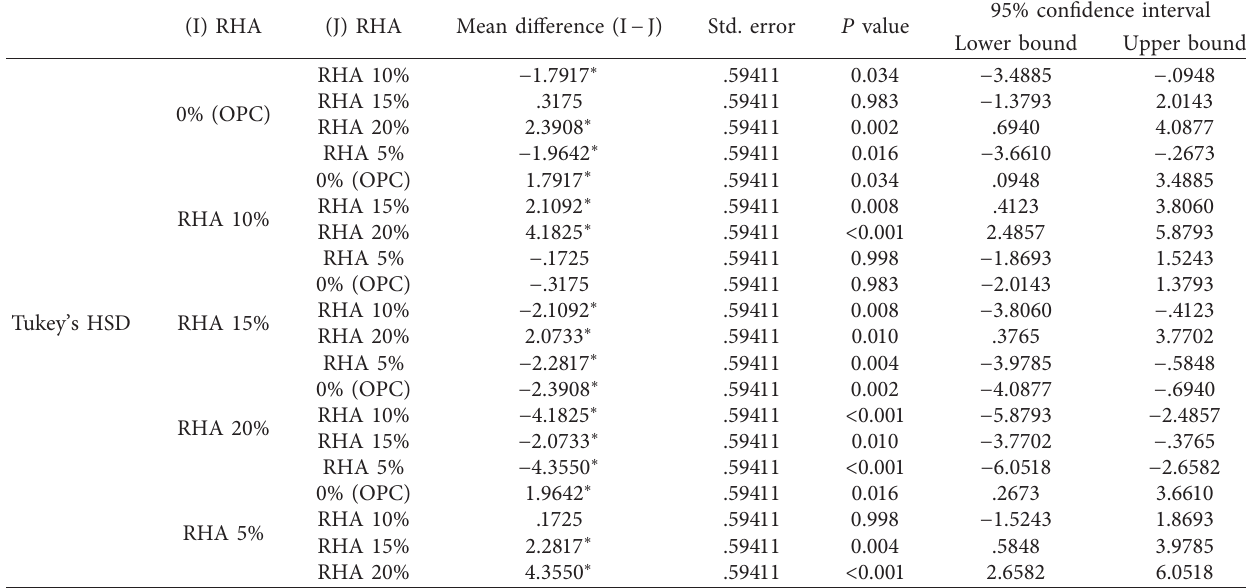
Table 7: Post hoc analysis for RHA